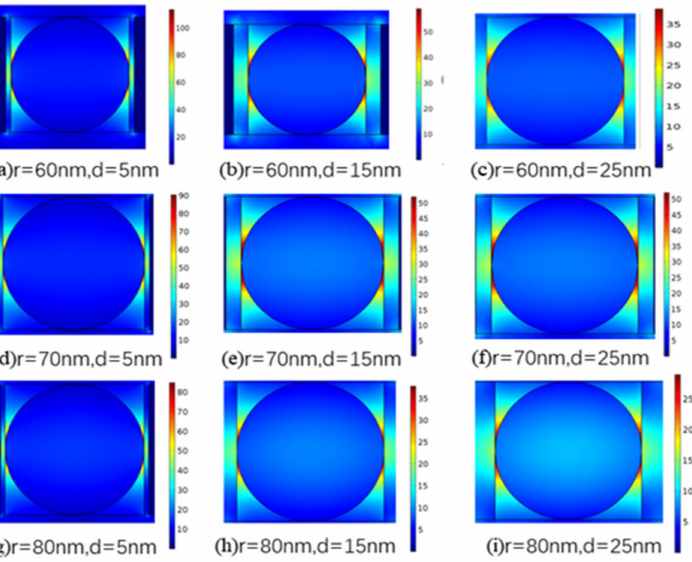
Figure 3. Electric field distributions for different values of nanowire radius r and dielectric layer thickness d . ( a ) r = 60 nm, d = 5 nm; ( b ) r = 60 nm, d = 15 nm; ( c ) r = 60 nm, d = 25 nm; ( d ) r = 70 nm, d = 5 nm; ( e ) r = 70 nm, d = 15 nm; ( f ) r = 70 nm, d = 25 nm; ( g ) r = 80 nm, d = 5 nm; ( h ) r = 80 nm, d = 15 nm; ( i ) r = 80 nm, d = 25 nm. When r is 60 nm and d is 5 nm, the electric field intensity has its highest value. When d and r increase, the electric field intensity decreases gradually. An increase in r causes the energy to converge gradually toward the